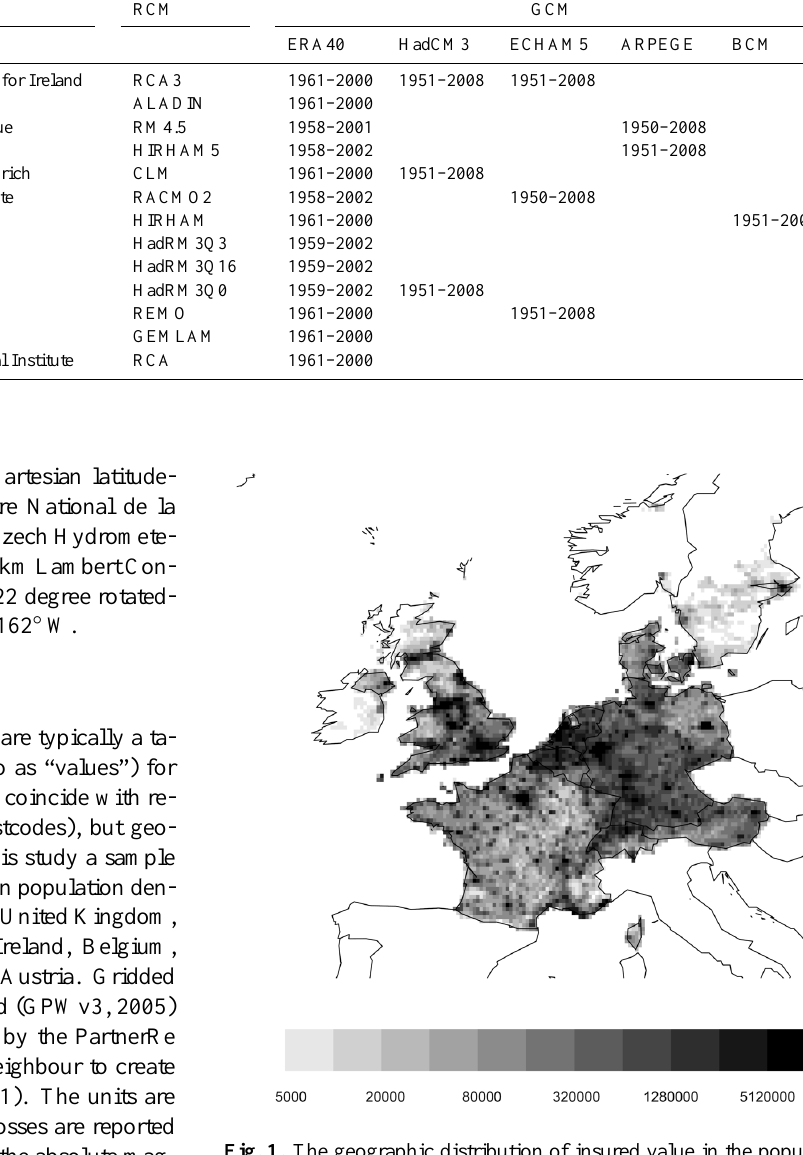
Fig. 1. The geographic distribution of insured value in the popula- tion density-derived portfolio. Units are people km − 2 ×